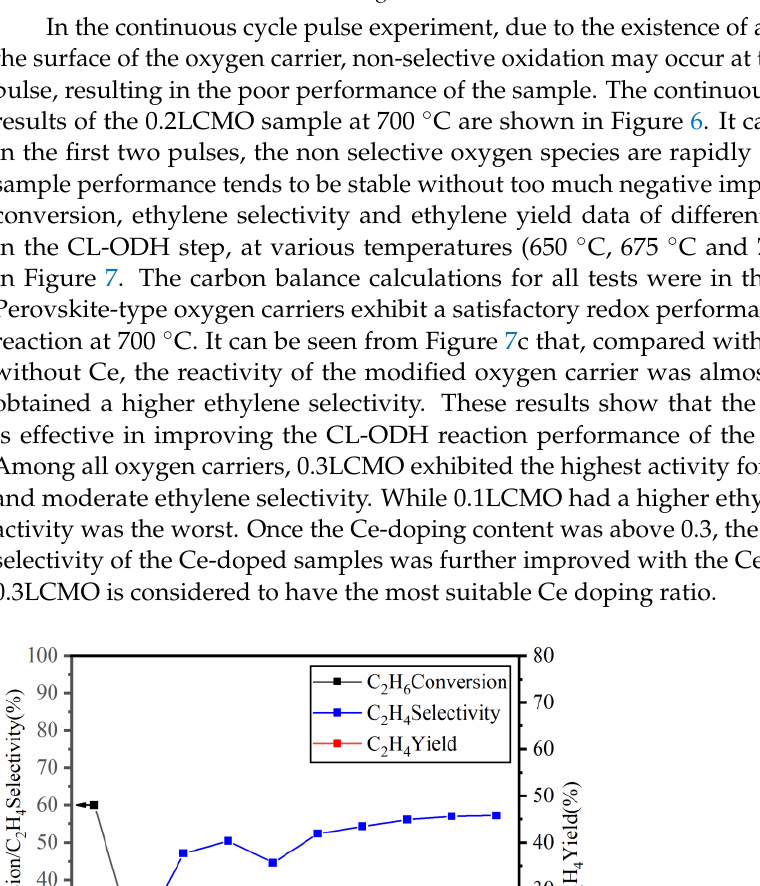
Figure 7. The ethane ODH reaction performances of different oxygen carriers at ( a ) 650 °C, ( b) 675 °C and ( c) 700 °C (GHSV = 1200 mL/h·g). 2.5. Cyclic Stability The excellent stability and recyclability of perovskite-type catalysts at high tempera- tures are critical for multiple redox cycles in the utilization of chemical looping. Therefore, the 0.3LCMO sample with the best reaction performance was subjected to 20 consecutive cycles of redox tests, and the reaction results are shown in Figure 8. In the ethane ODH step, the conversion of ethane fluctuated slightly between 35 — 40%, while ethylene selec- tivity remained in the range of 25 — 30%, and the yield did not decline significantly after 20 cycles. The XRD results (Figure 9) can further confirm the structural stability of the 0.3LCMO sample. The sample after the re-oxidation cycle obtained the same XRD patterns as the fresh sample, and the characteristic peaks after successive redox cycles were domi- nated by LaMnO 3 characteristic peaks. In addition, it is noted that the sample showed weak peaks at 2θ = 34.9° and 2θ = 40.5° after cycling, which corresponded to MnO [34]. The SEM-EDS results (Figures 10 and 11) show that the structure of the circulating sample remains good after the cycle, and all elements are evenly distributed in the oxygen carrier.